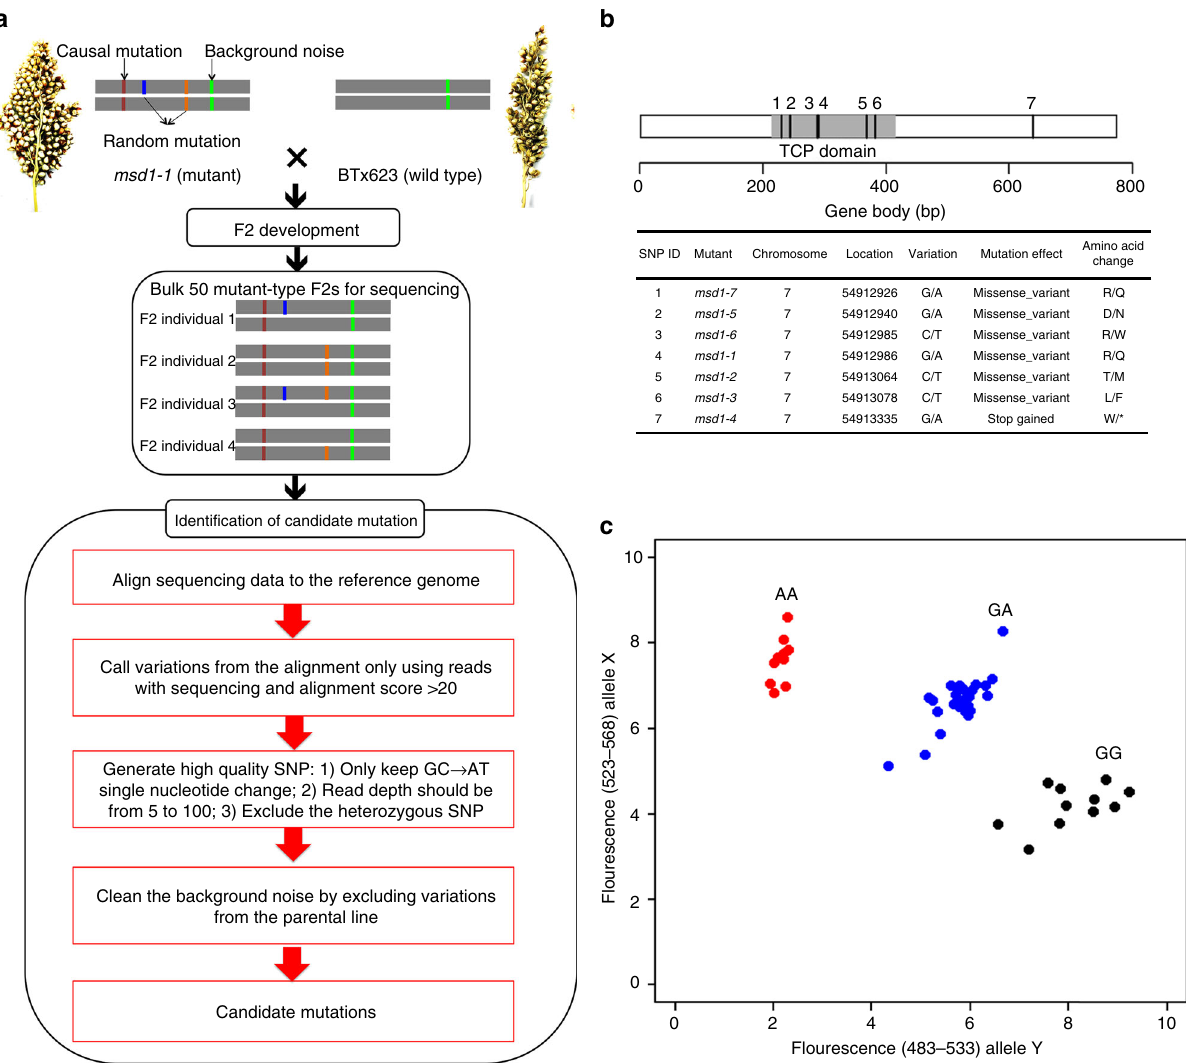
Fig. 2 Identi fi cation of MSD1 gene in sorghum. a Work fl ow of bulk segregant analysis combined with whole-genome sequencing, used to identify the causal gene in an msd1-1 F 2 population. b Structure of MSD1 (Sb07g021140), depicting the CDS of 774 nucleotides and the TCP domain. The table below shows alleles of msd1 identi fi ed by sequencing of 15 msd mutants. c Co-segregation of the msd1-1 mutation in Sb07g021140 with the msd phenotype was analyzed in an F 2 population derived from a cross of RTx437× msd1-1 . Among the 48 individual F 2 plants, 10 with homozygous mutations (AA) had msd panicles, whereas the rest (11 homozygous WT [GG] and 27 heterozygous [GA]) had WT panicles. The phenotype distribution for this population fi t a 3:1 WT: msd ratio, with 100% co-segregation of the mutant genotype with the